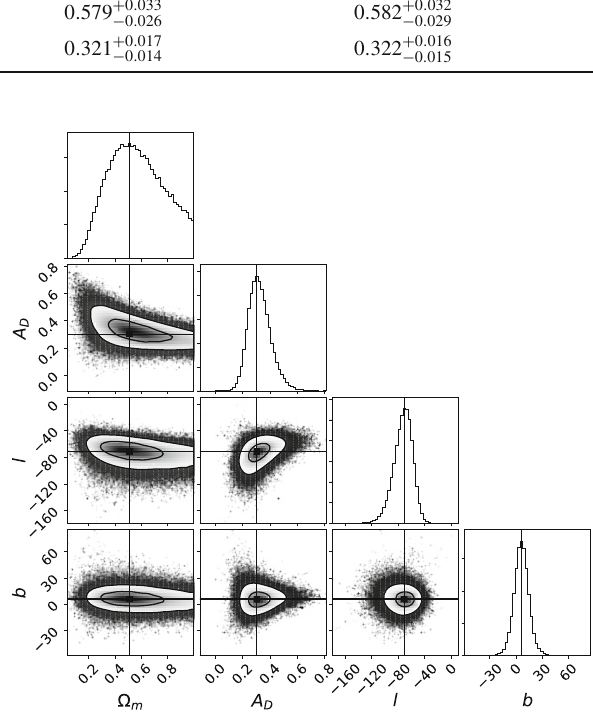
Fig. 2 The marginalized posterior distribution of the parameters in the Finslerian cosmological model with the 2015 quasar compilation. The horizontal and vertical solid black lines denote the maximum of 1-dimensional marginalized